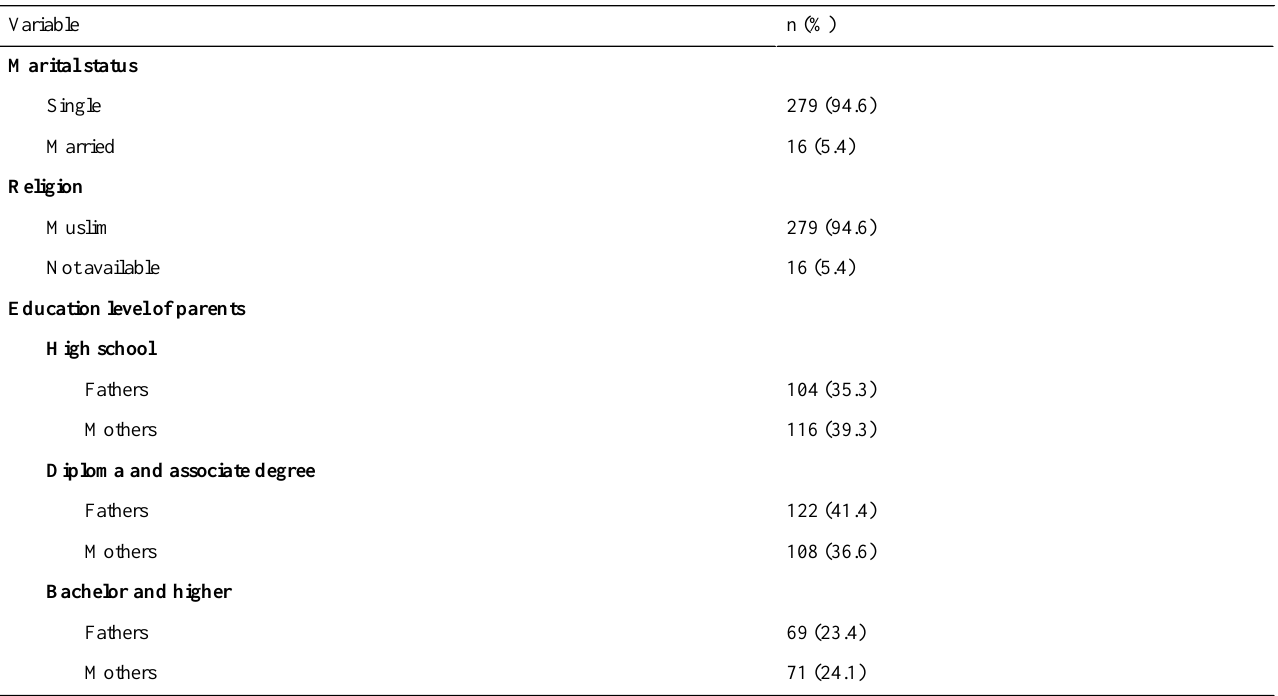
Table 1. Demographic characteristics of the participants (N=295).